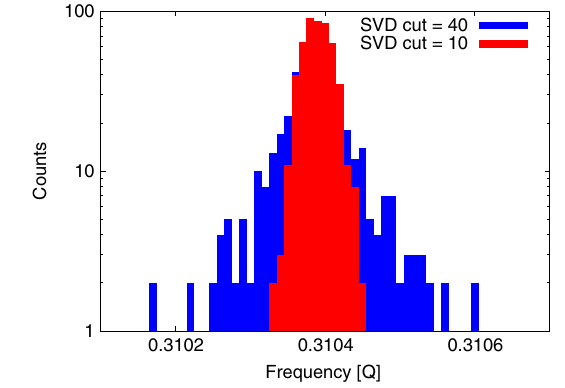
FIG. 6. Tune distribution of all LHC BPMs for SVD cuts of 10 and